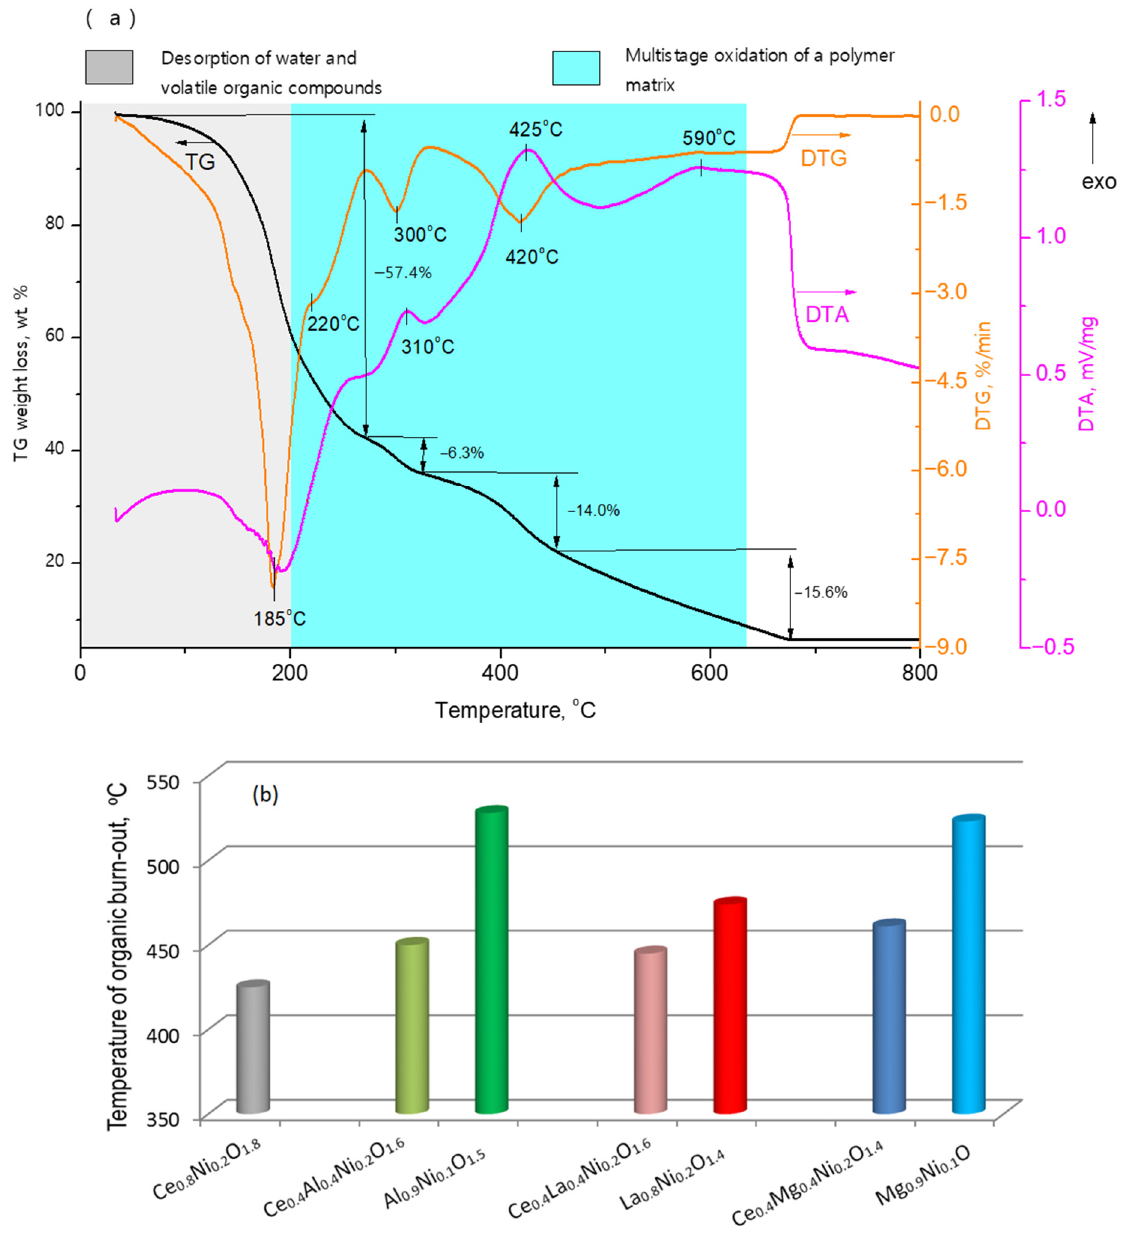
Figure 2. Thermal analysis of the gel-precursor for Ce 0.8 Ni 0.2 O 1.8 sample ( a ) and effect of oxide matrix composition on the temperature of organics burn-out during TA of gel-precursors ( b ).